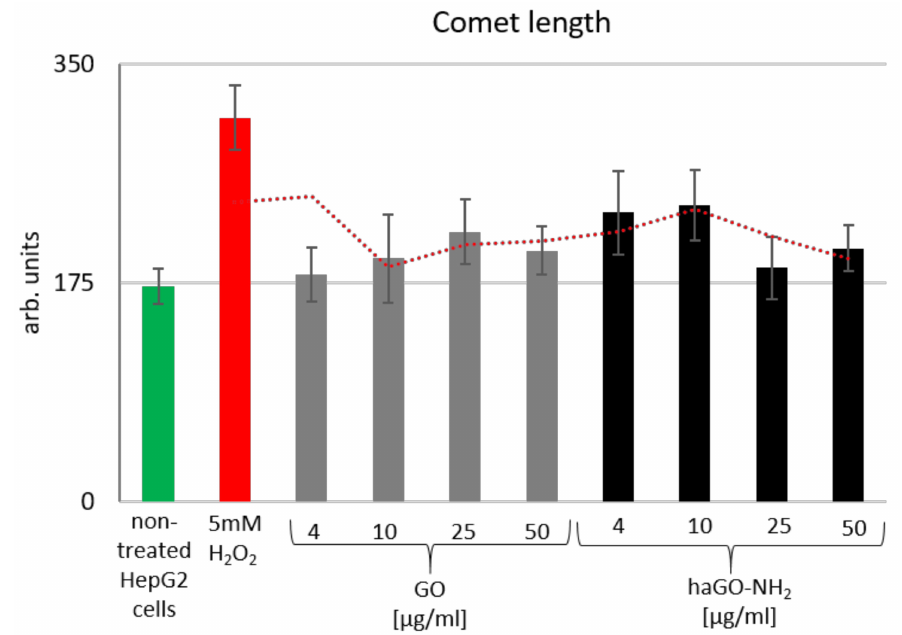
Figure 7. SCGE for testing the genotoxicity potential of pristine and aminated GO nanoparticles on HepG2 cells. Graphical representation of the parameter “Comet length” as quantified by the software CometScore. Data are represented as MEAN ± STDV, where n = 100. Additionally, the given trend represents the moving average values for Comet length measured for all probes including the positive control for genotoxicity - HepG2 cells treated with 5 mM H 2 O 2